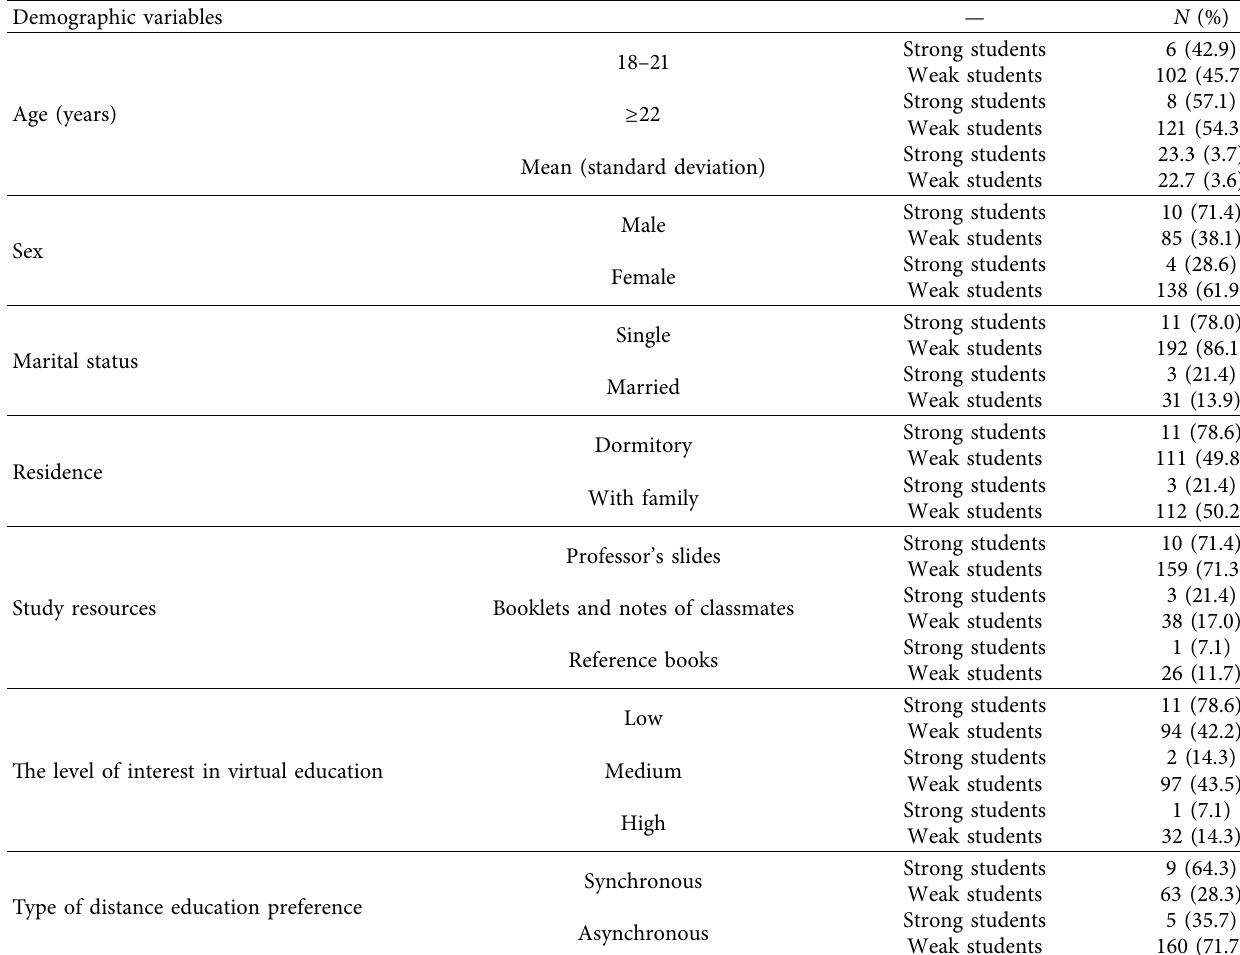
Table 1: Demographic characteristics of students.